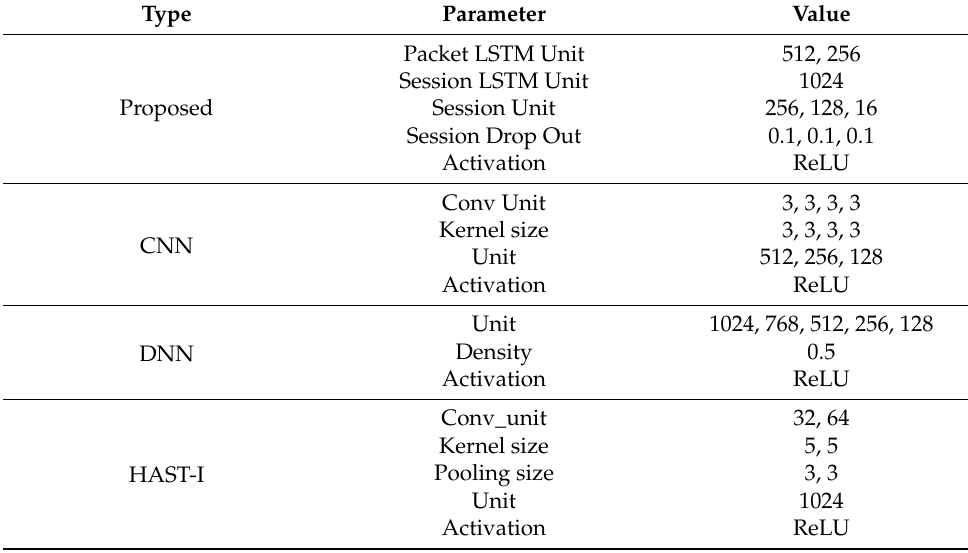
Table 7. Parameter configuration for each